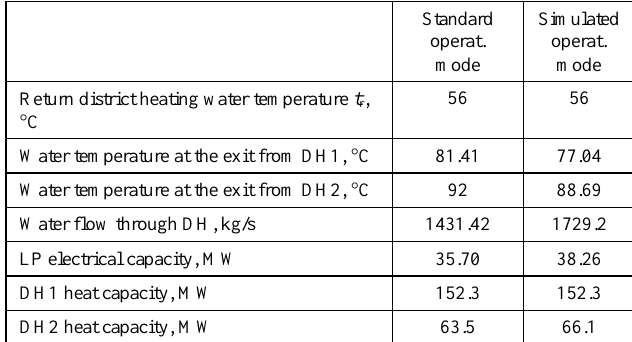
E XAMPLE OF C OMPARISON OF S TANDARD AND S IMULATED O PERATIONAL M ODES (L OAD 100 %, A MBIENT T EMPERATURE −8 °C) Standard